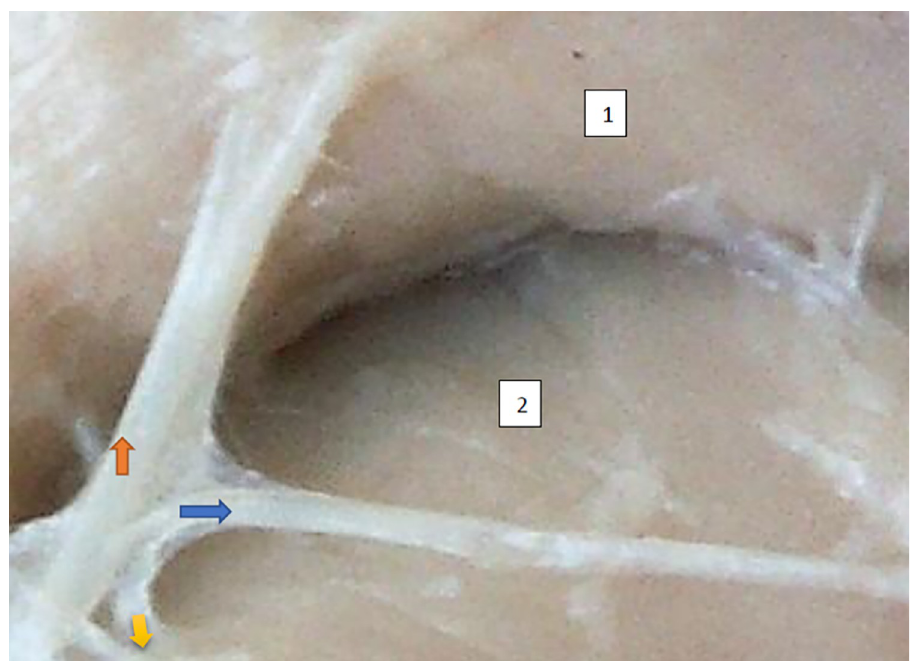
Fig 4. Superior gluteal nerve, tree type, morphological age 124–18–V, V–tub 130,V–pl 190, mass 140, male sex, magnification 30x. 1– gluteus medius muscle, 2– gluteus minimus muscle, red arrow–branch to gluteus medius muscle, yellow arrow–branch to gluteus minimus muscle, blue arrow–branch to tensor fasiae latae muscle.